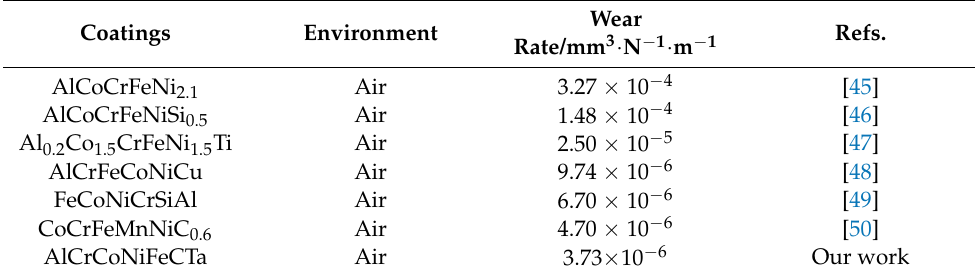
Table 4. Comparison of wear rates of high-entropy alloy (HEA) coatings in air between our works and the relative